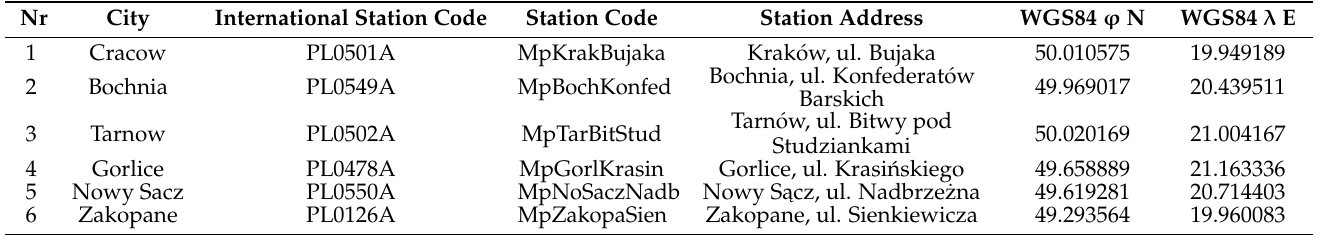
Table 2. Analyzed urban background measurement stations operating in Cracow and selected